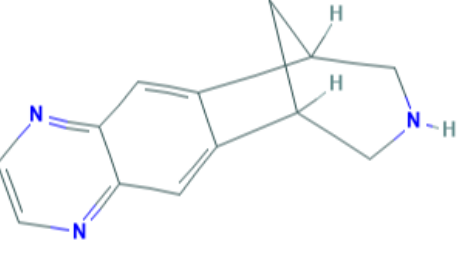
Figure 1. Chemical structure of varenicline. Source: PubChem database.